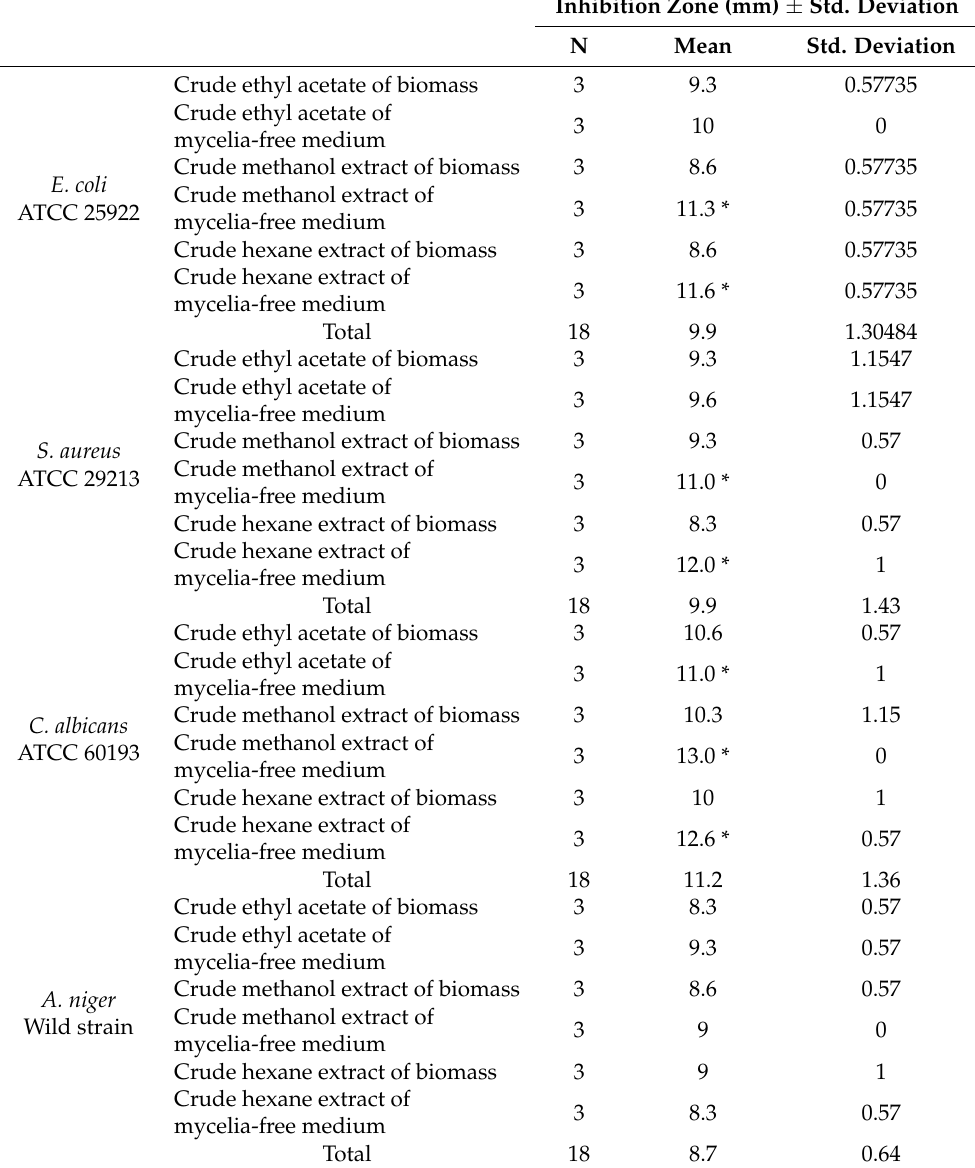
Table 7. The biological activity of the crude extracts obtained from the biomass of T. nevia and mycelia-free medium (N =